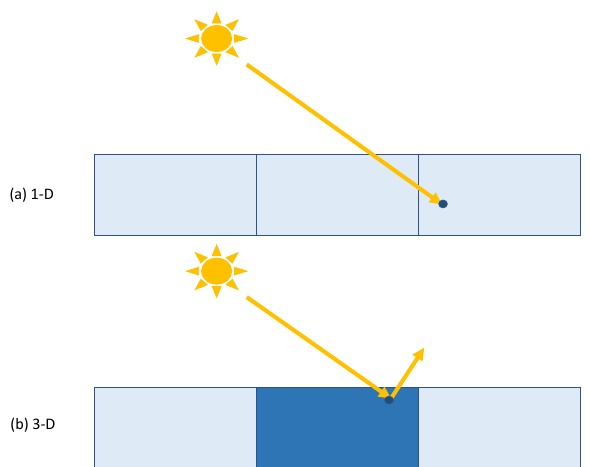
Figure 7. Illustration of the shadowing effect. In 1-D (a) , the right column can be illuminated by the photon coming from the Sun, while in 3-D (b) an optically thick neighbor region scatters the pho- ton first, increasing the reflectance of the thick region but reducing the reflectance of the thin